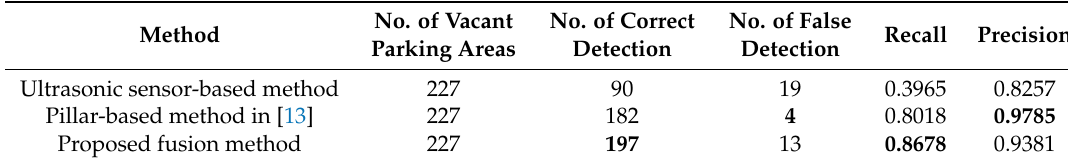
Table 2. Performance comparison of parking area detection methods in UG.